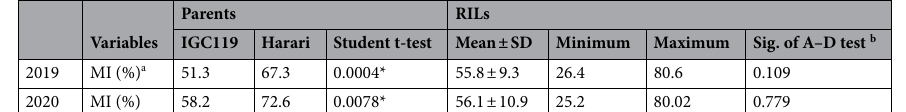
Table 1. Summary statistics of MI trait among parents and RILs. a MI (%), maturity index; b significance for normality test by Anderson—darling test; *significant at P < 0.01.